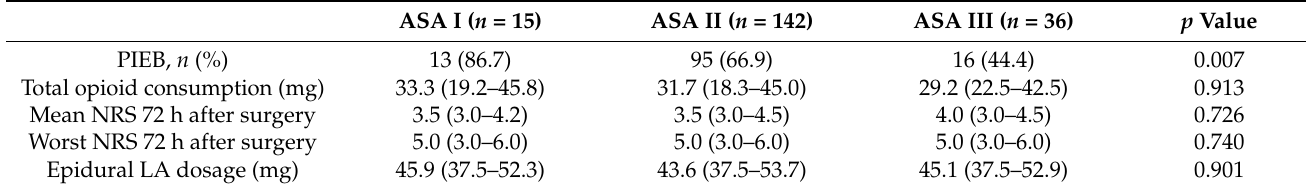
Table 2. Outcome variables according to ASA